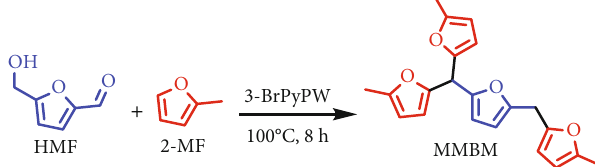
Scheme 2: The synthesis of C fuel precursor (MMBM) from the 21 trimerization of HMF with 2-MF catalyzed by